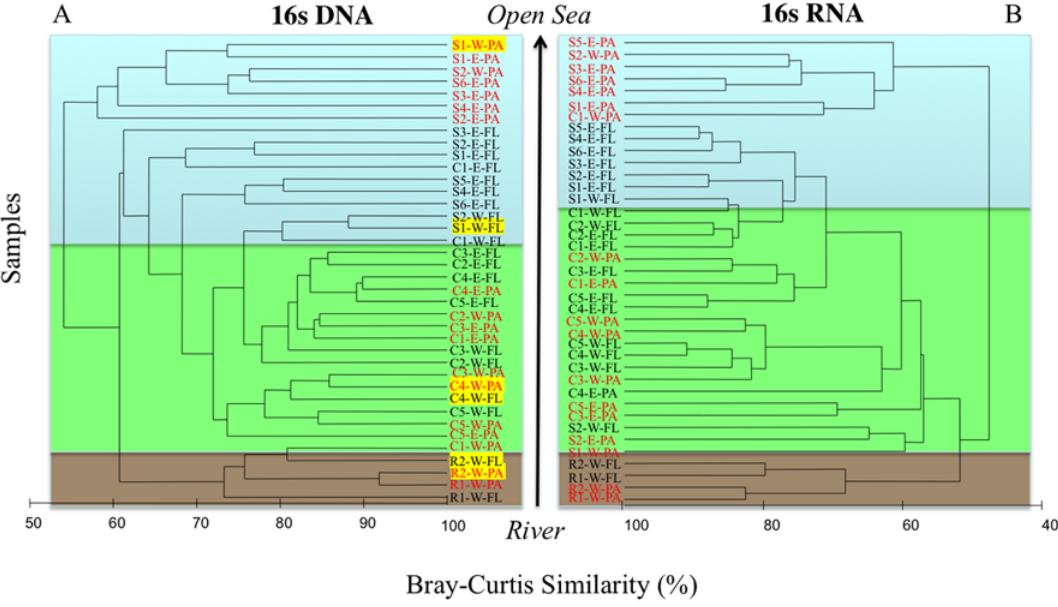
Fig. 2. Unweighted-pair group method with arithmetic mean (UPGMA) dendrograms based on Bray–Curtis similarities of DNA-based (A) and RNA-based (B) CE-SSCP fingerprints of particle-attached (PA, red letters) and free-living (FL, black letters) bacteria. Blue rectangles: stations considered as “open sea” (S). Green rectangles: stations considered as “coast” (C). Brown rectangles: stations considered as “river” (R). W: western transect. E: eastern transect. Samples selected for tag pyrosequencing are highlighted in